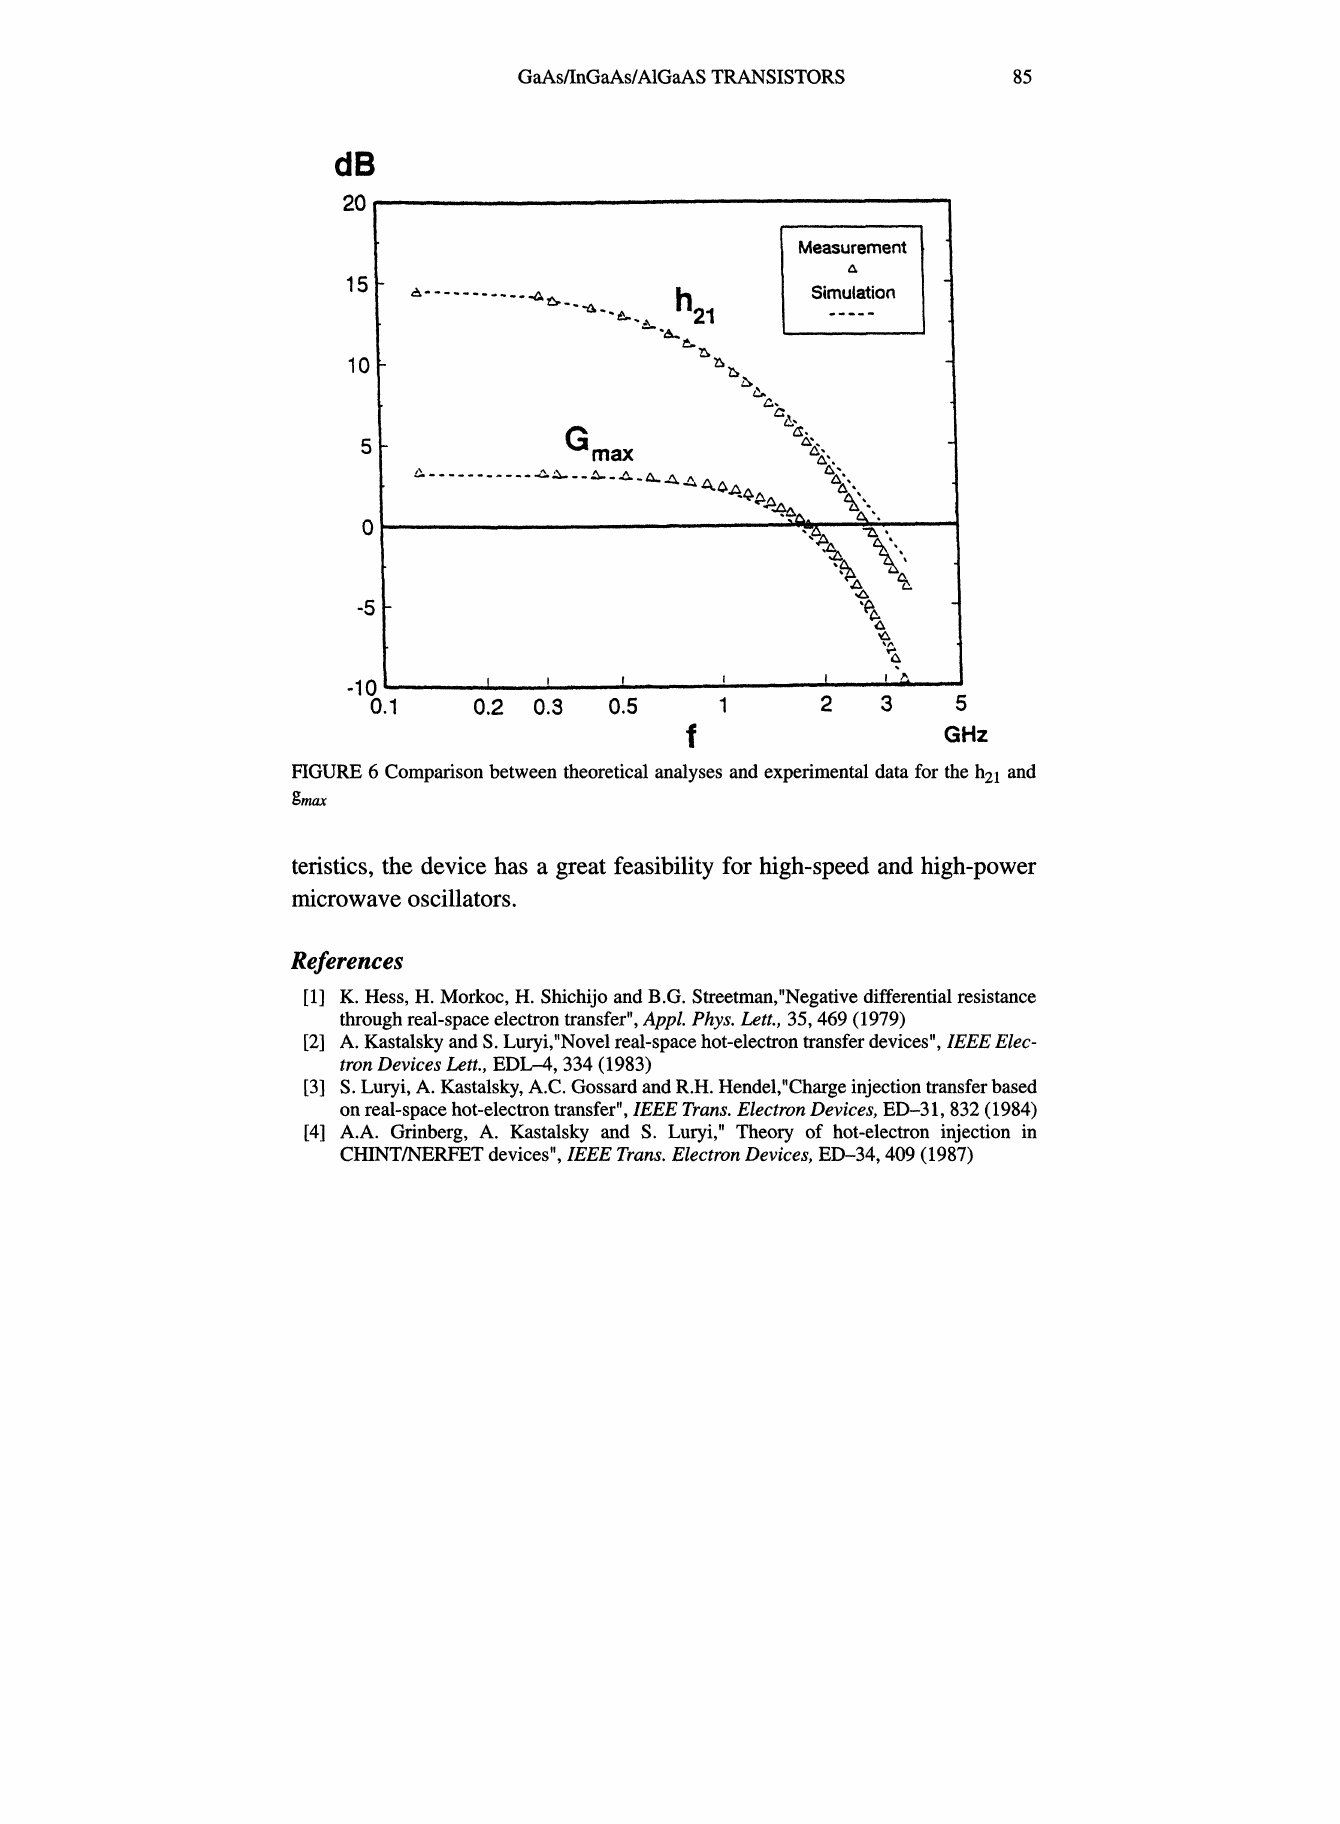
FIGURE 6 Comparison between theoretical analyses and experimental data for the h21 and gmax teristics, the device has a great feasibility for high-speed and high-power microwave